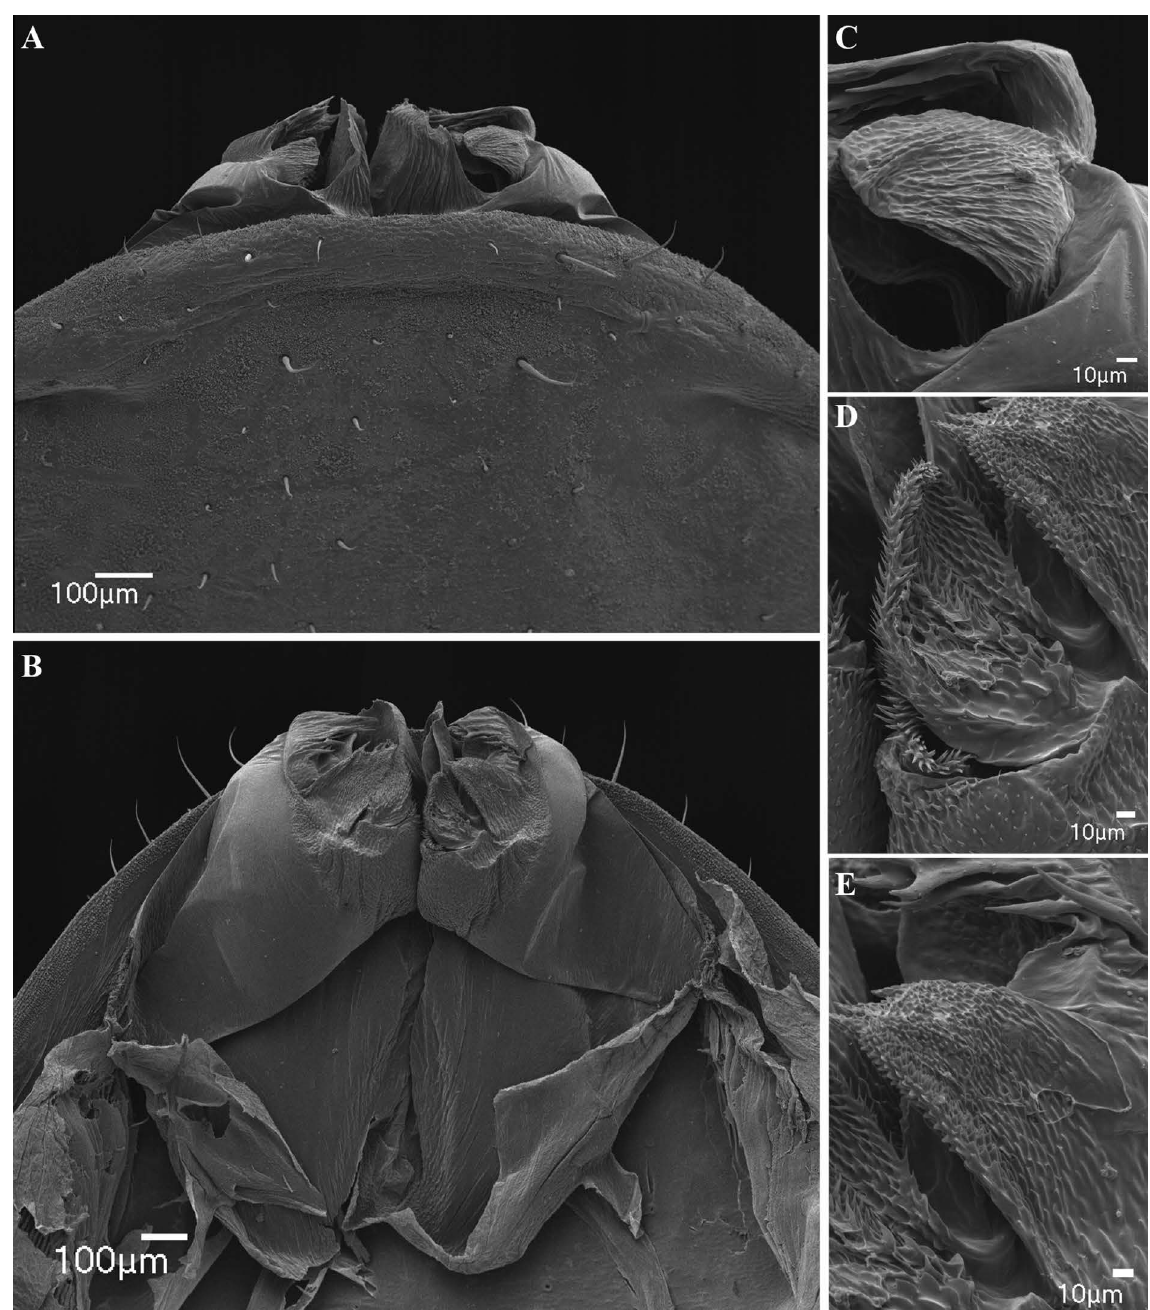
Fig. 92. Charinus loko sp. nov. (SMNS), male gonopod. A . Ventral view. B . Dorsal view. C . Dextral side of gonopod. D . Lateral lobe 1. E . Dorsal